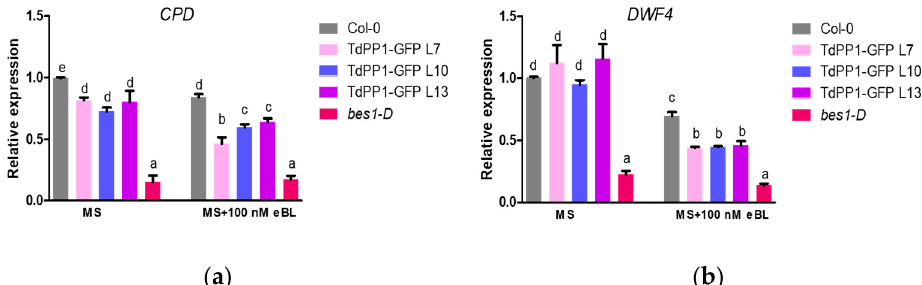
Figure 3. Relative expression of BR-biosynthesis genes CPD and DWF4 . ( a ) Analysis of CPD and ( b ) DWF4 , BR-responsive gene expression in Arabidopsis WT plants, TdPP1-GFP OE lines (L7, L10 and L13) and bes1-D . Plants were grown on half-strength MS medium for 7 days and transferred to half MS-strength liquid medium without or with 100 nM BL for 1 h. Seedlings were collected and the expression level of CPD and DWF4 was quantified by qRT-PCR using the ACT2 and GAPC2 gene as reference genes. The expression of CPD and DWF4 was normalized to the expression of ACT2 . Data represent mean values and error bars are SD from the average of three biological replicates (10 seedlings per biological replicate). Letters indicate statistically significant differences between WT vs TdPP1-GFP OE (L7, L10 and L13) and bes1-D as determined by one-way ANOVA followed by Tukey’s multiple comparison test ( p -value < 0.05).